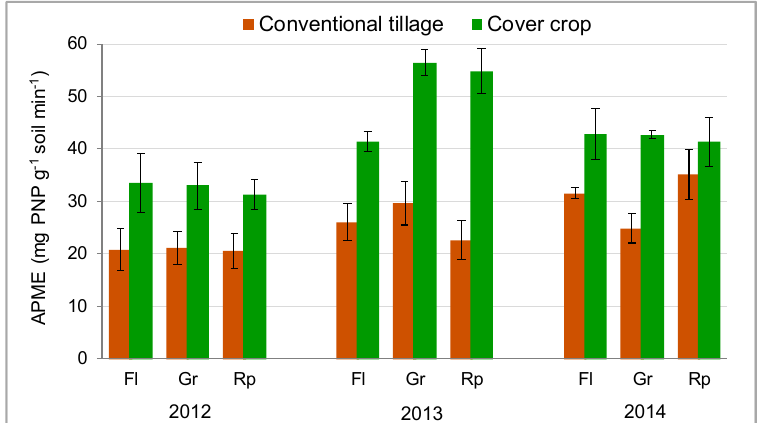
Figure 5. The trend of alkaline phosphomonoesterase activity (APME) in soil subjected to conventional tillage or cover crop during flowering (Fl), fruit growth (Gr) and ripening (Rp) in the three years of experimentation. The bar on each column indicates the standard deviation (n = 3).